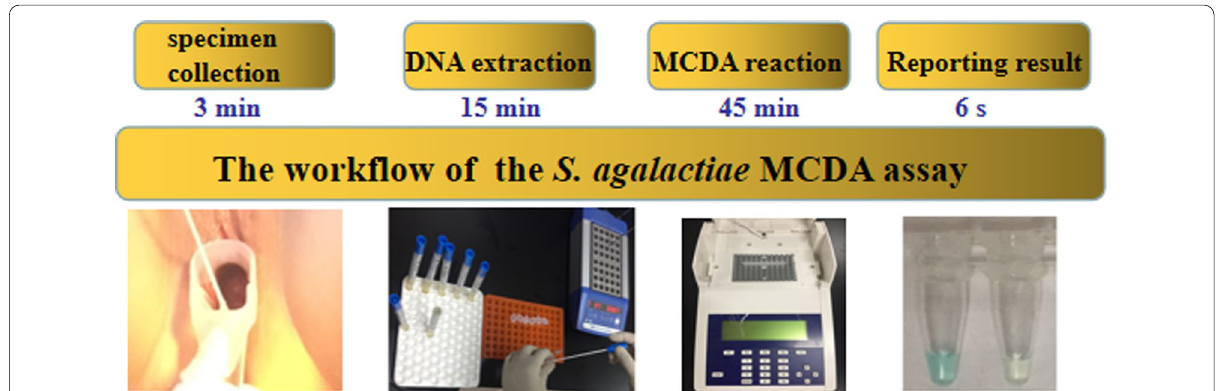
Fig. 7 The workflow of the S. agalactiae MCDA assay. Four steps were required for completing S. agalactiae MCDA test, including sample collection (3 min), DNA preparation (15 min), MCDA reaction(45 min) and result reporting (6